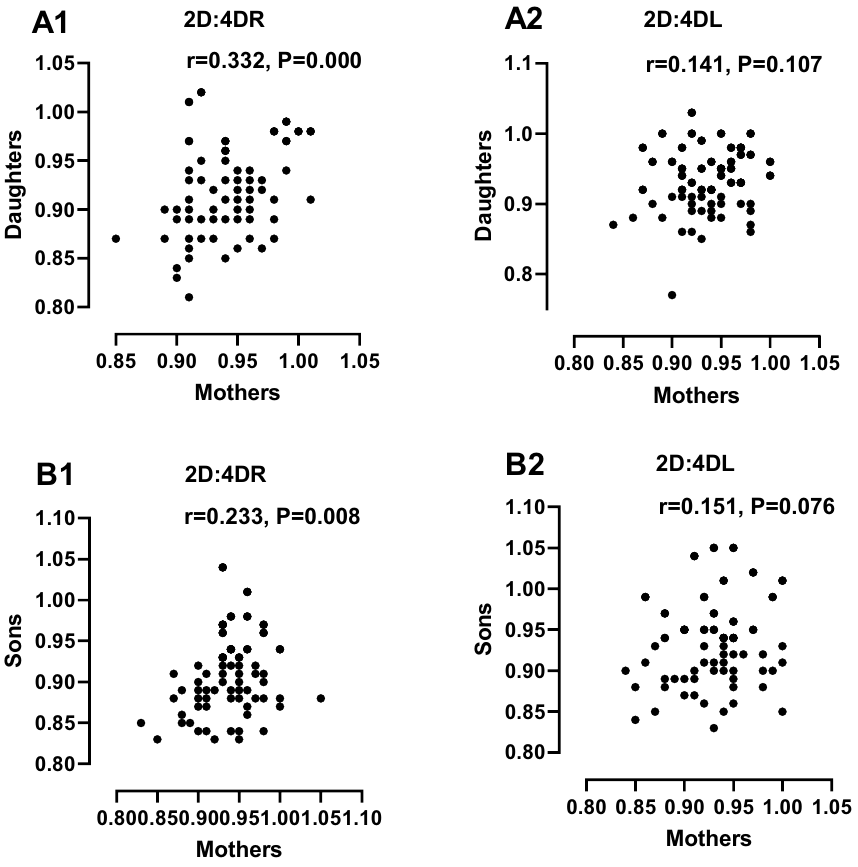
Figure 4. Pearson correlation scatterplots of digit ratios between mothers and their children: correlation of digit ratios between mother and daughter ( A1 = 2D:4DR, A2 = 2D:4DL), correlation of digit ratios between mother and son ( B1 = 2D:4DR, B2 =